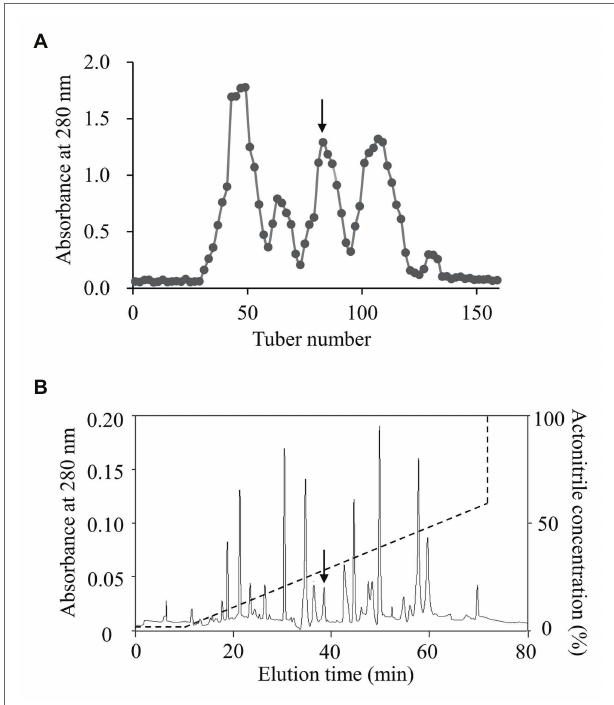
FIGURE 1 | Purification of AMP from topmouth culter. (A) Sephadex G-50 gel filtration. The homogenates of head kidney were applied to Sephadex G-50 gel filtration column and eluted with 0.1 M PBS at a flow rate of 3 ml/10 min, and the fraction containing antimicrobial activity was marked by an arrow. (B) The antimicrobial fraction from Sephadex G-50 gel filtration was separated by a C18 RP-HPLC column with the indicated gradient of acetonitrile in 0.1% (v/v) trifluoroacetic acid in water, and the eluted peak containing antimicrobial activity was marked by an arrow.